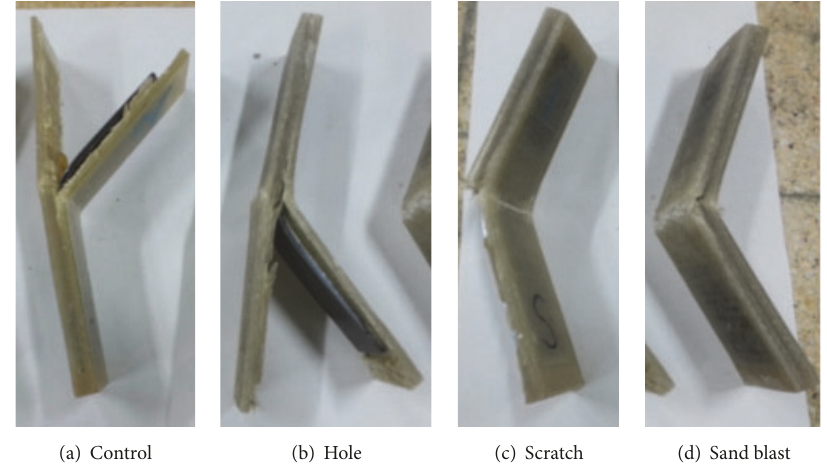
Figure 9: Fracture deformation after flexural